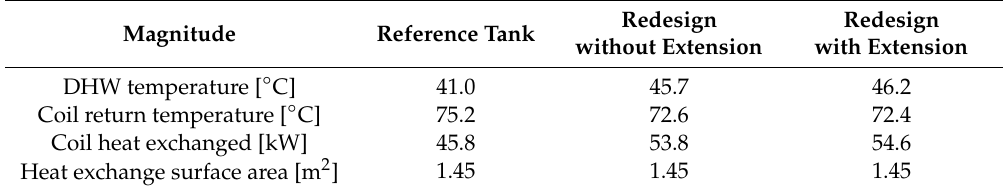
Figure 13. Comparison of the temperature fields inside the reference tank and the redesigned tanks. Table 4. Comparison of the results of the continuous consumption simulation in the reference tank and the redesigned